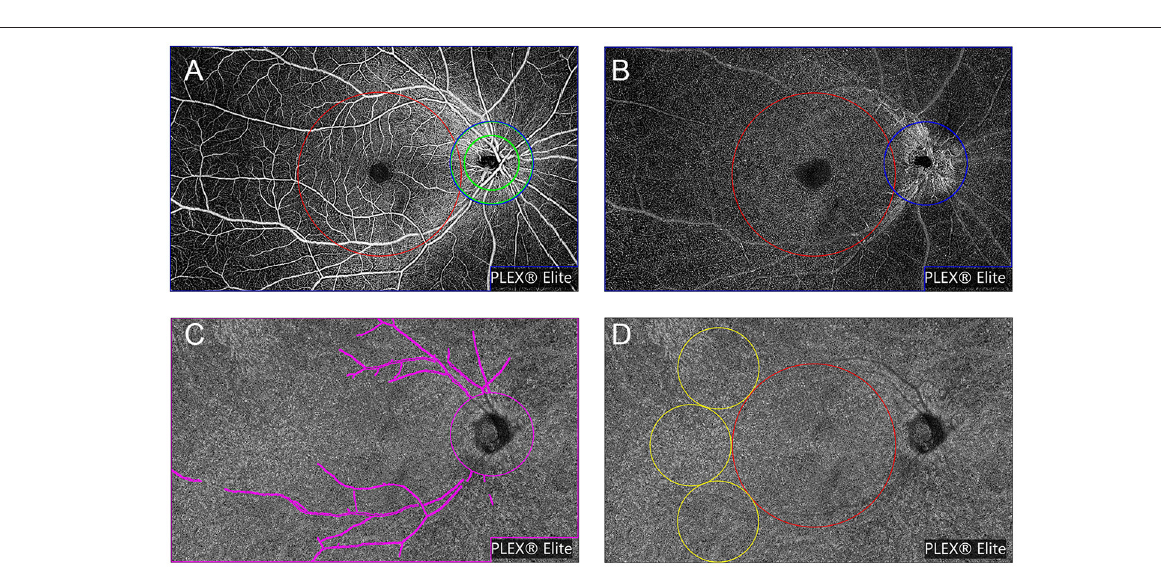
FIGURE 2 | Representation of the regions used to explore OCTA parameters, slabs are from a healthy volunteer (No. 13, the right eye). OCTA parameters were investigated in different regions of the superficial vascular plexus (SVP) slab (A) and deep vascular plexus (DVP) slab (B) : (1) the macular region (red circle with a diameter of 6mm centered at the fovea); (2) the peripapillary region (a 500 µ m-wide ring of 2mm inner diameter and 3mm outer diameter centered at the optic nerve head) (green annulus); and (3) the whole field of view (FOV) with optic papilla area (a 3mm diameter circle) and the image label “PLEX® Elite” excluded (cropped) (blue polygon shape). (C) Representation of whole FOV removing the large retinal vessel mask used to explore OCTA parameters in choriocapillaris slab (shown in magenta). (D) Representation of regions to explore flow voids metrics: (1) the macular region (shown in red) and (2) the peripheral region (three 3 mm-diameter circles next to the macular region) (shown in